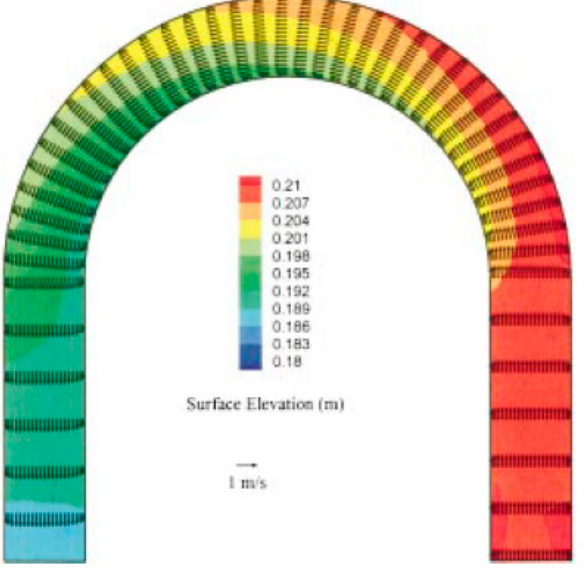
Figure 6. Surface elevation and velocity vector field (Reproduced from Duan (2004) [50] with permission from ASCE) .